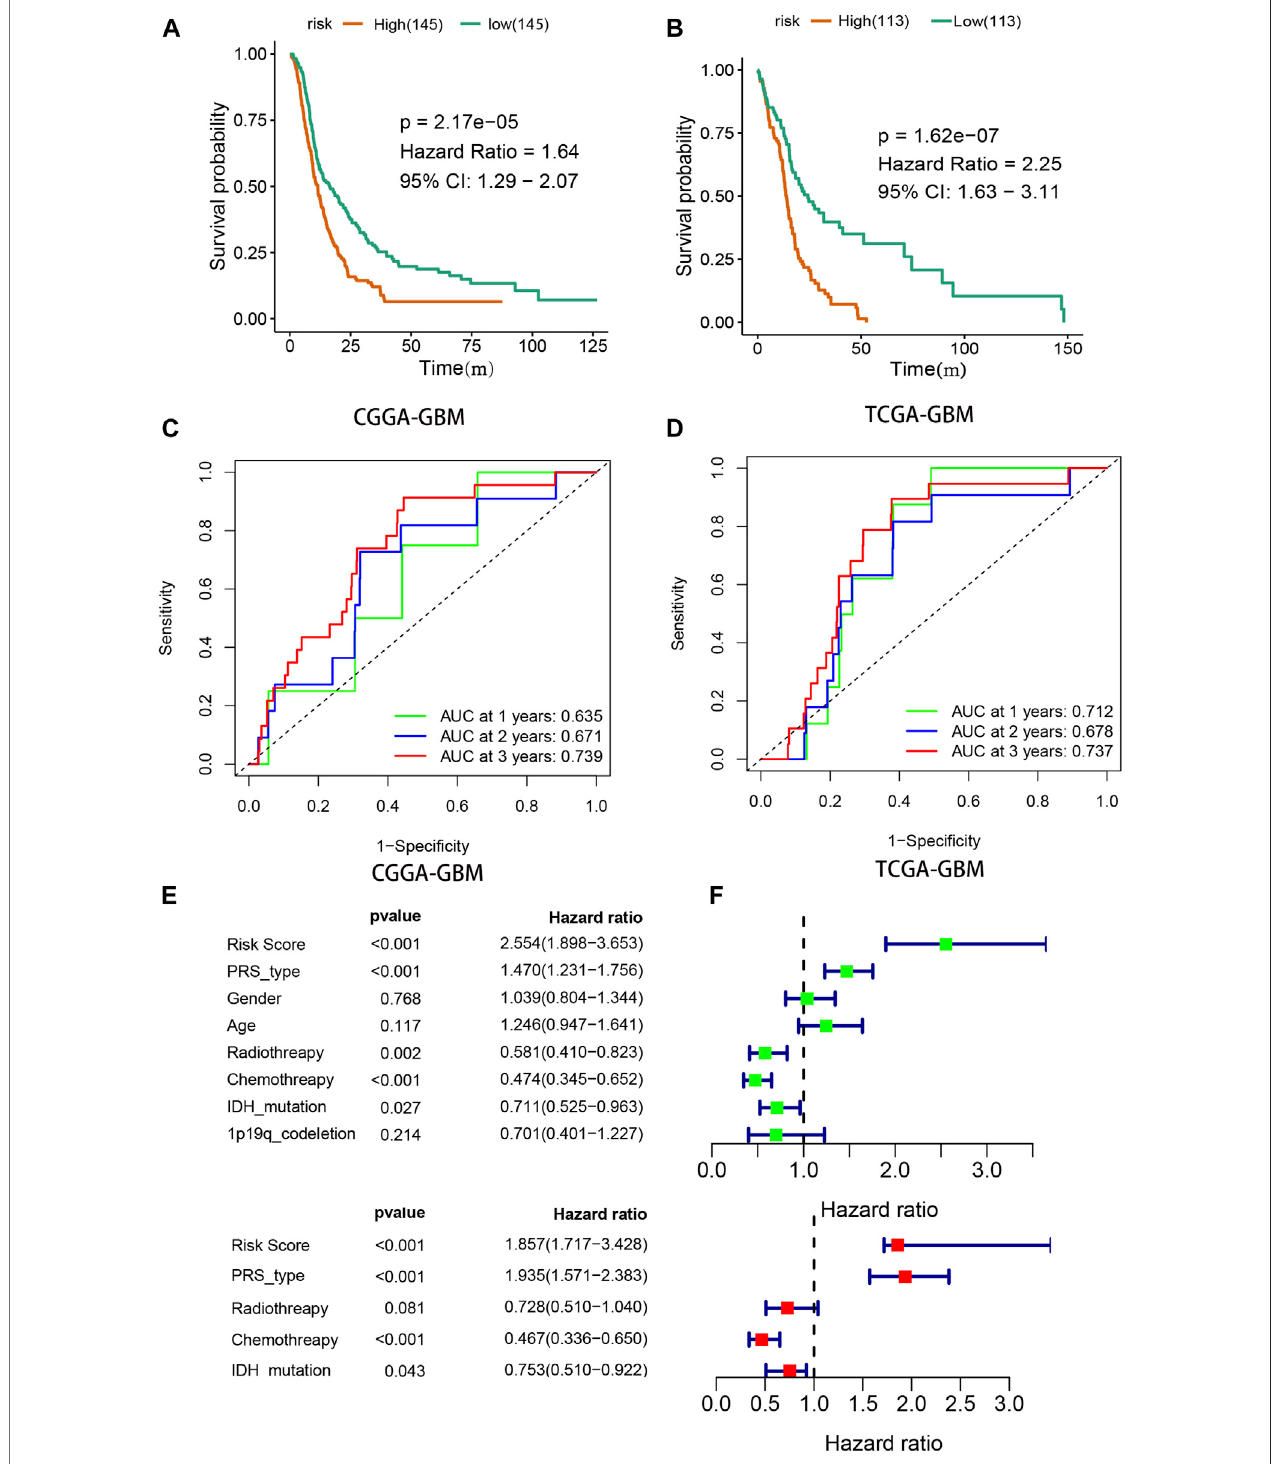
FIGURE 4 | Validation of prognostic signature. (A,B) Survival analysis for high- and low- risk GBM patients in CGGA and TCGA. (C,D) Receiver operator characteristic curve analysis of signature. AUC, area under the curve. ( E,F ) Univariate and multivariate analysis of risk signature.